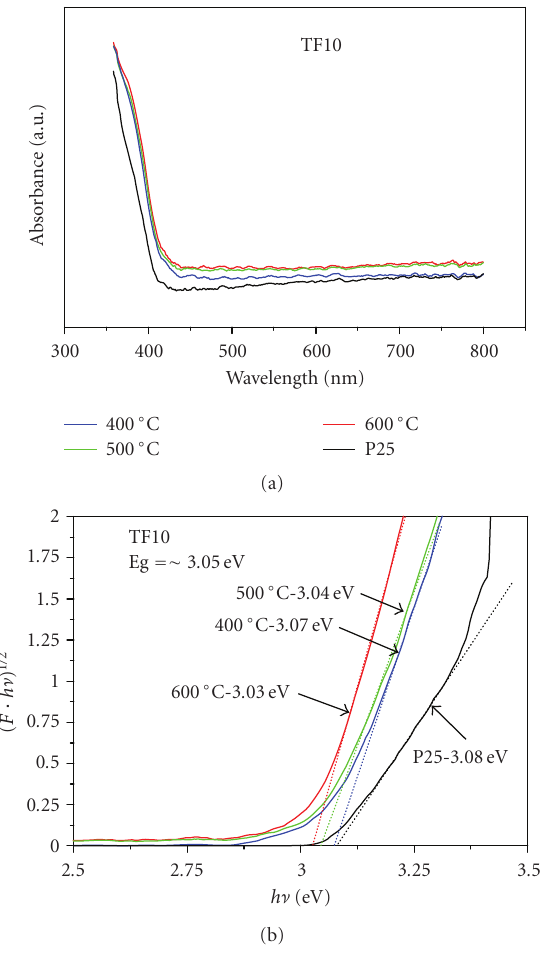
Figure 6: Absorbance spectra (a) and Kubelka-Munk plot for band gap evaluation (b) of fluorinated (TF10) TiO 2 and P25 powders.